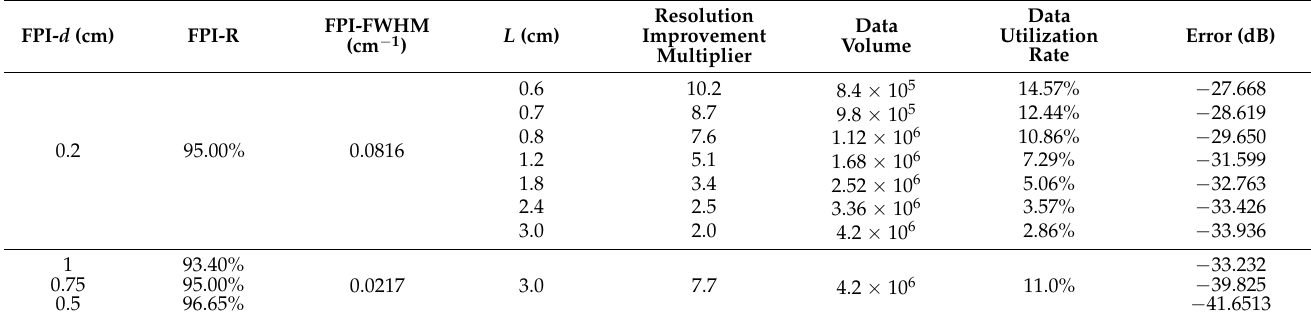
Table 1. Parameters and results of the RS-HI